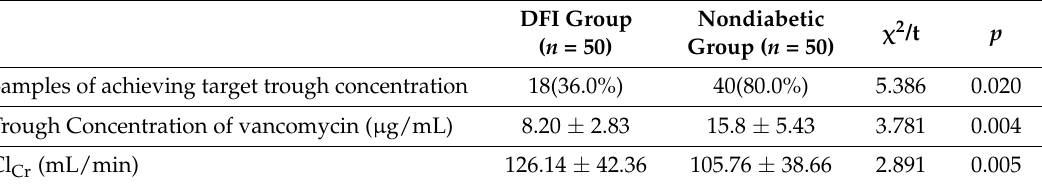
Table 4. Comparison of DFI group and nondiabetic